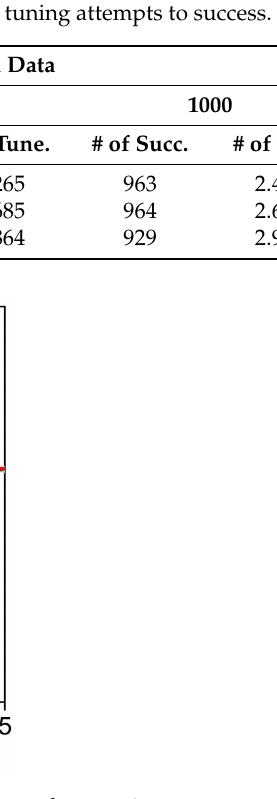
Figure 7. Response graphs of L-11-1000 with noise that changed as tuning was repeated for m = 38.08 kg, k = 80.73 N/m, and c = 807.74 N · s/m. Table 5. Number of successful tuning attempts and average number of tuning attempts to success using LSTM networks by reducing the number of learning data. The number “1000” in the method L-21-RC-1000 and L-11-1000 means that these methods trained only 1000 of the total data. Method with